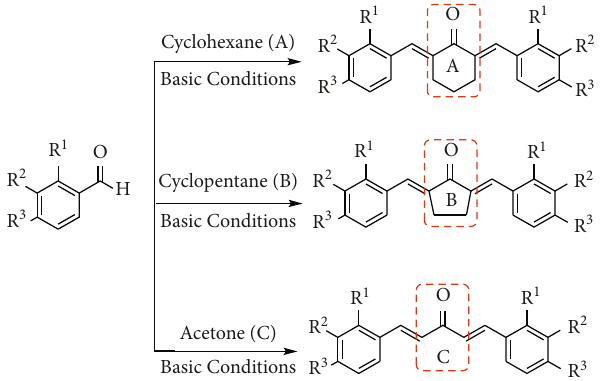
SCHEME 1: Synthesis of curcumins 1–8